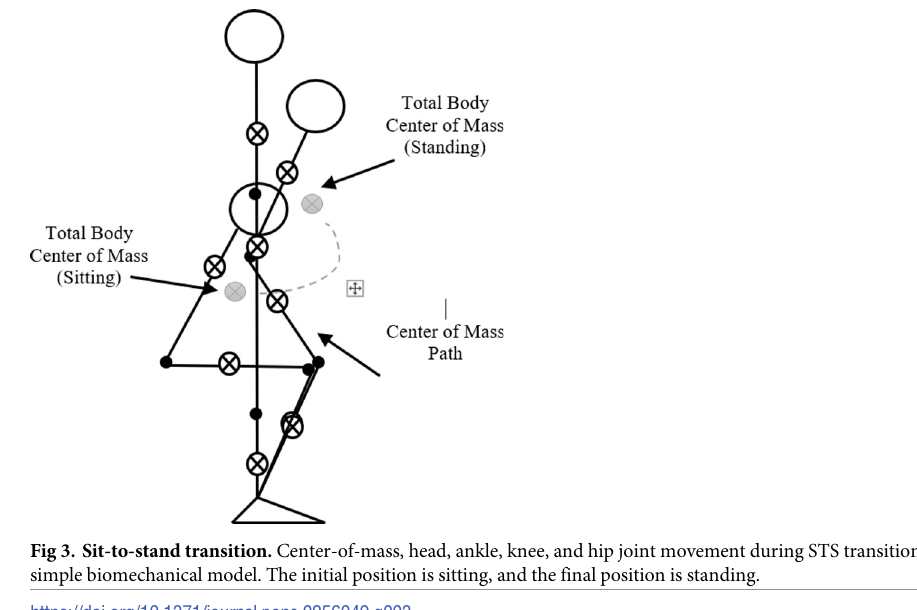
head position. All simulations are done in SI units i.e., time in seconds (s), force in Newtons (N), torque in N-m, and angles in radians (rad). Simulation results show the comparison of